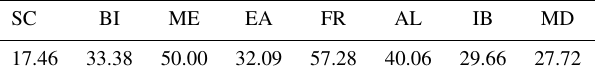
Table 4. Percentages of the selected pixels with a test R 2 score ≥ 50% in the PRUDENCE regions (percent).